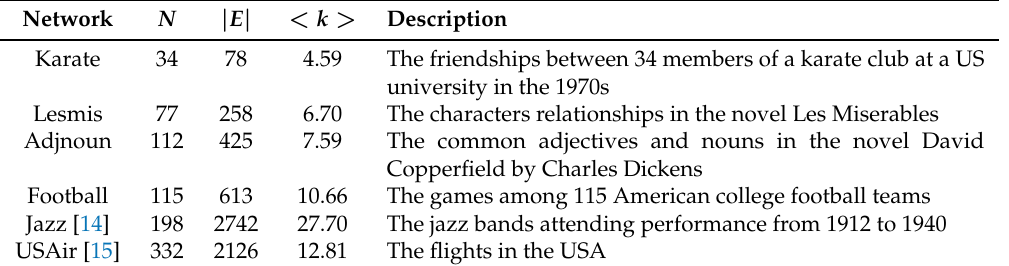
Table 1. The parameter of real network. The quantities N , | E | , < k > represent the number of nodes, the number of edges and the average degree,